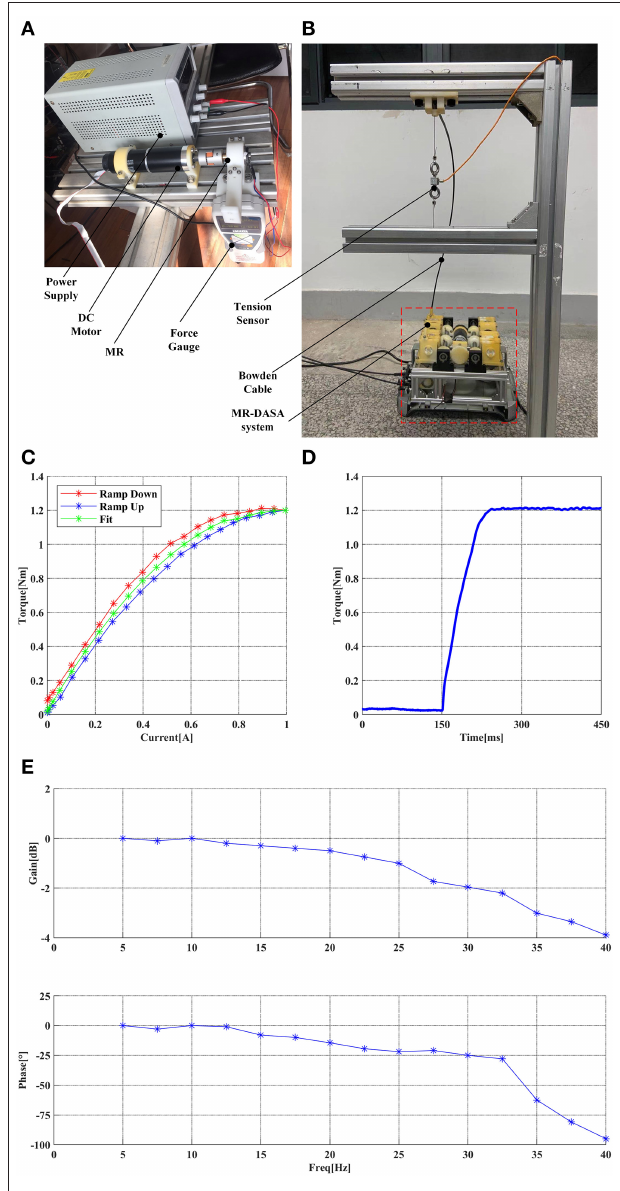
FIGURE 8 | (A) the MR performance test platform, (B) the MR-Cable system performance test platform, (C) the MR current-torque curve, (D) the MR step response curve, (E) the MR-Cable closed-loop force control Bode